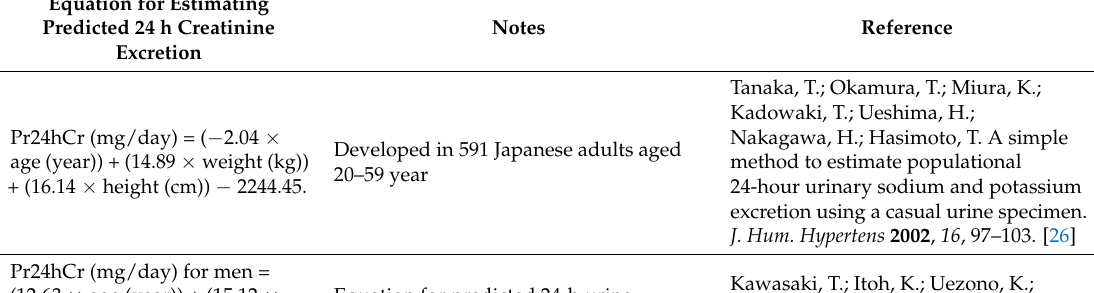
Table 1. Prediction equations used to estimate 24 h urinary creatinine excretion (PrCr).